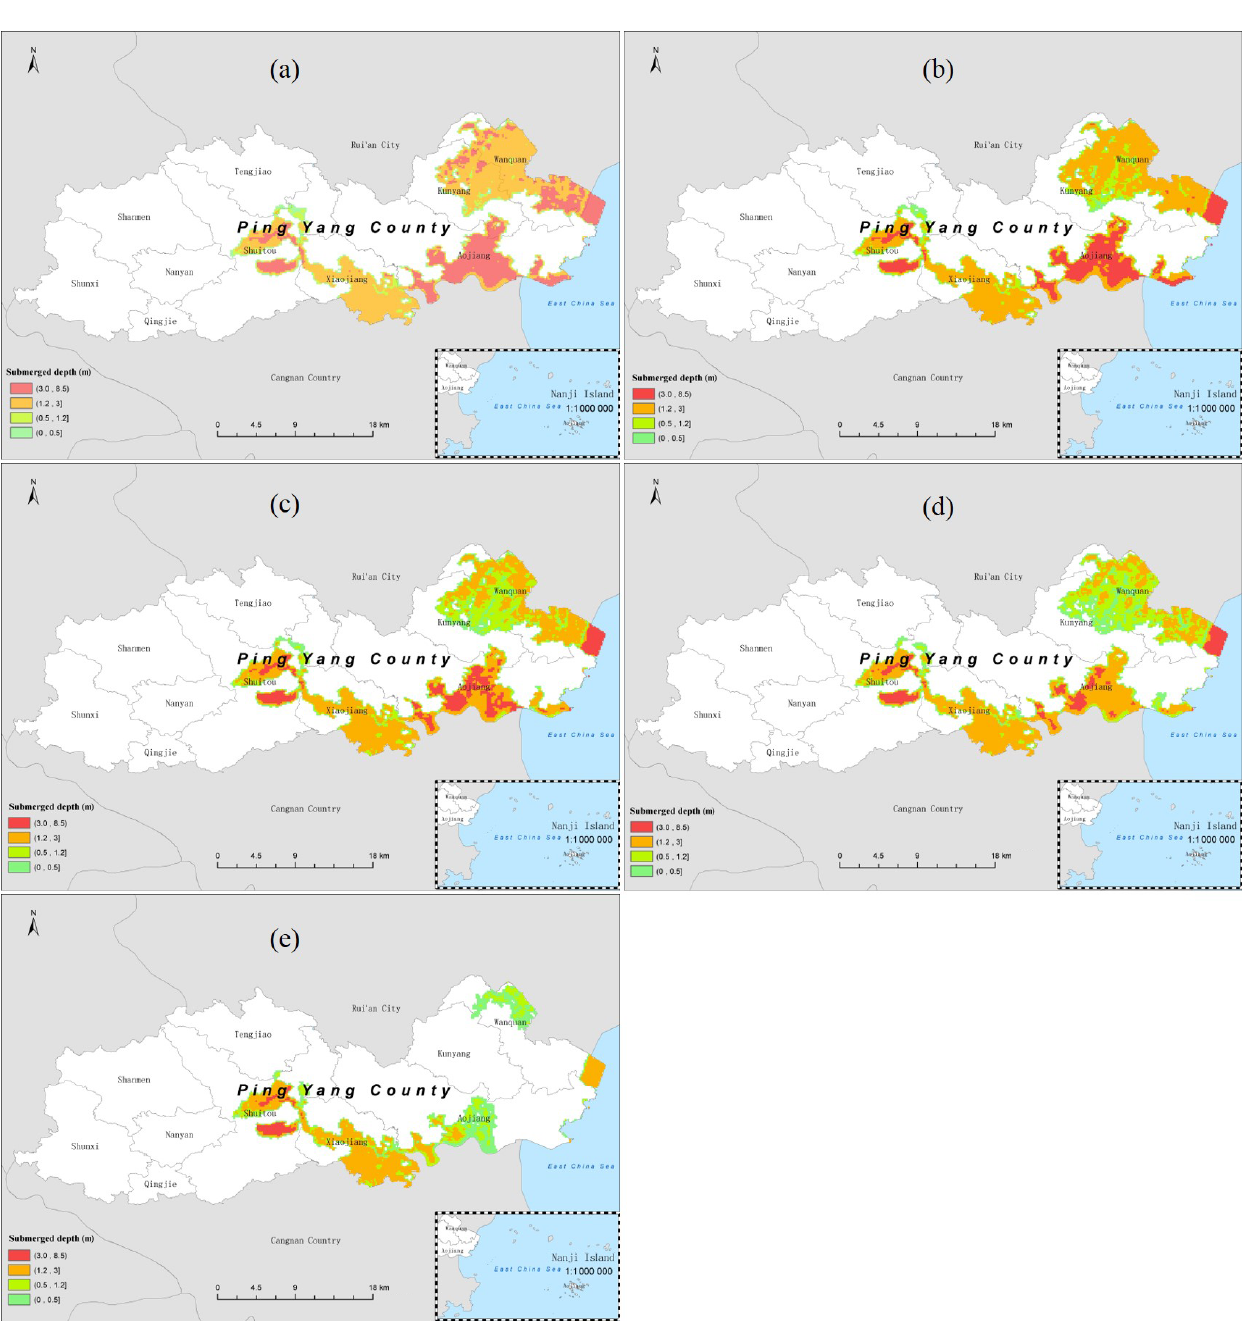
Figure 12. Inundation range and water depth distribution of storm surges associated with typhoons of different intensity: (a) 915hPa, (b) 925hPa, (c) 935hPa, (d) 945hPa, and (e)